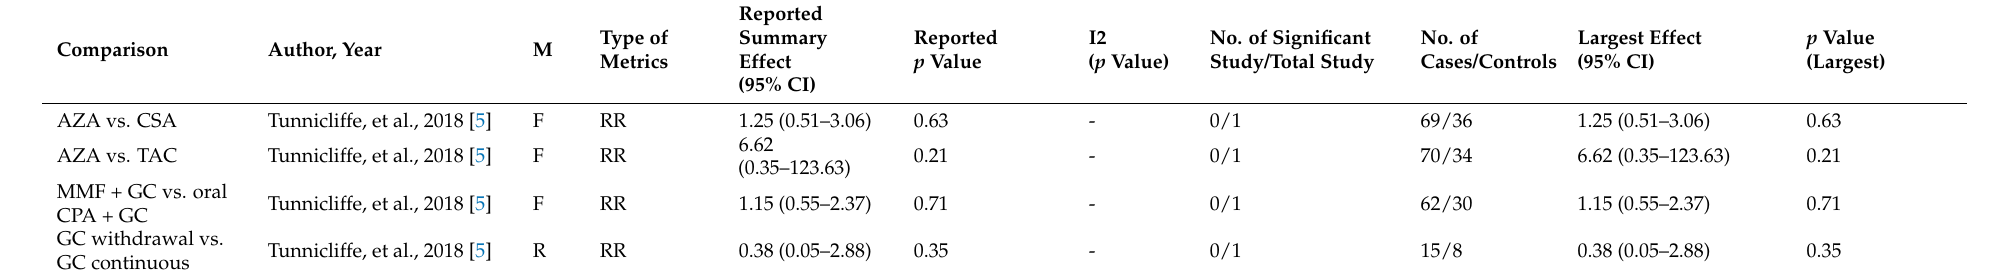
Table 4. Relapse during maintenance therapy of lupus